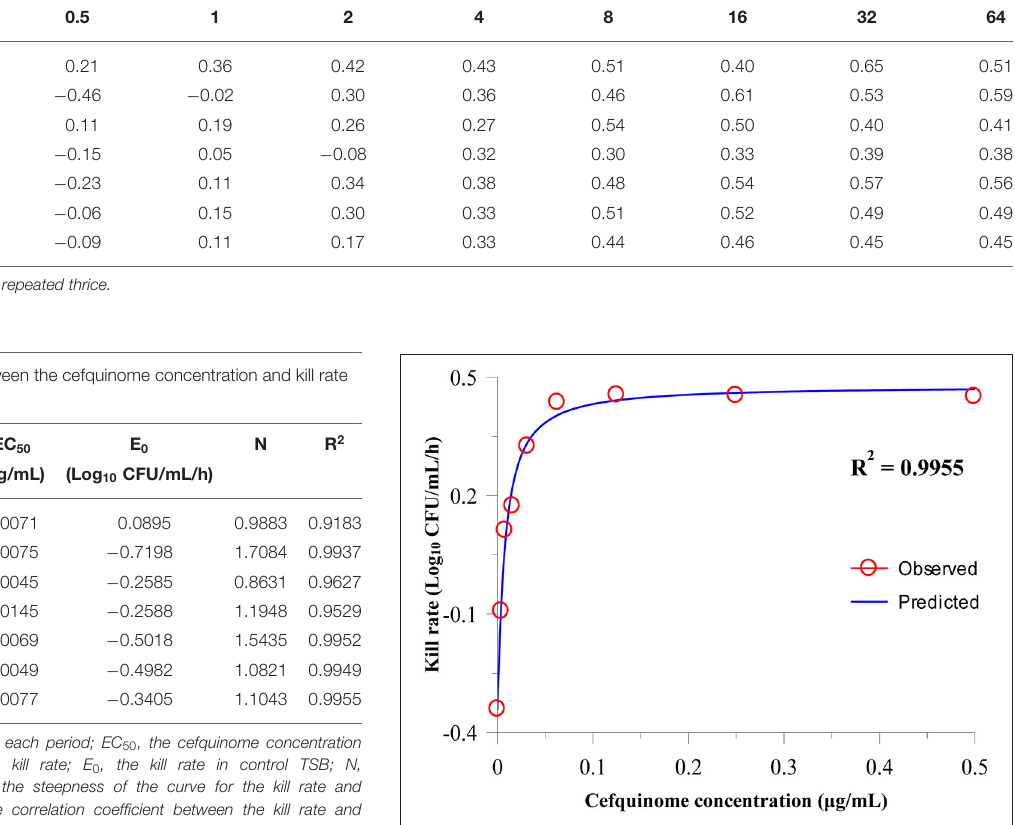
TABLE 1 | Kill rate (Log 10 CFU/mL/h) at different time intervals at different concentrations of cefquinome against A. pleuropneumoniae in TSB. Concentrations of cefquinome in TSB ( × MIC)